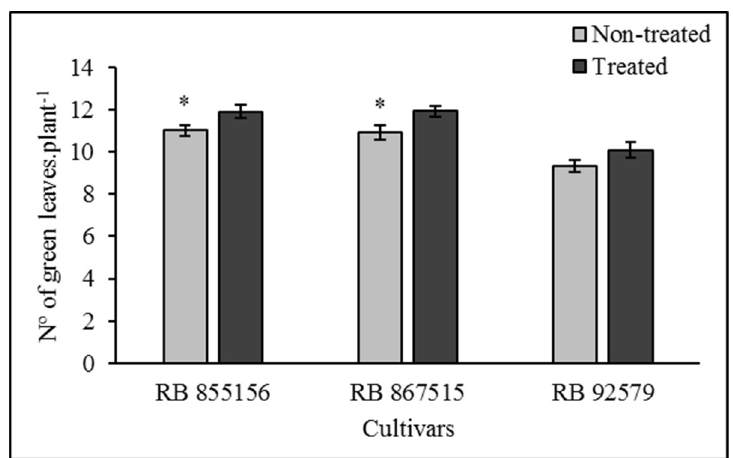
Figure 6. Average number of green leaves in sugarcane plants treated with the fungicide, pyraclostrobin, compared to control plants. The results represent the average of six evaluation times and three replications. * Indicates a significant difference among treatments by the Tukey test at 5% probability. The bar indicates the standard error of the mean.